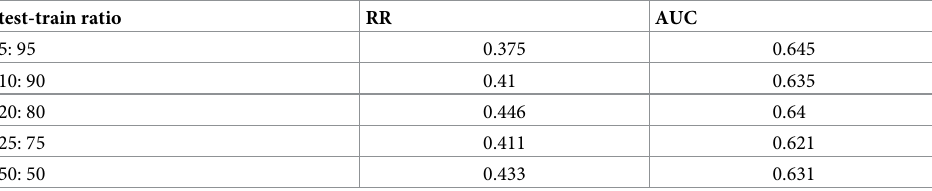
Table 6. Train-test ratio influence on the performance of the DPNN model with the MDD data, medians